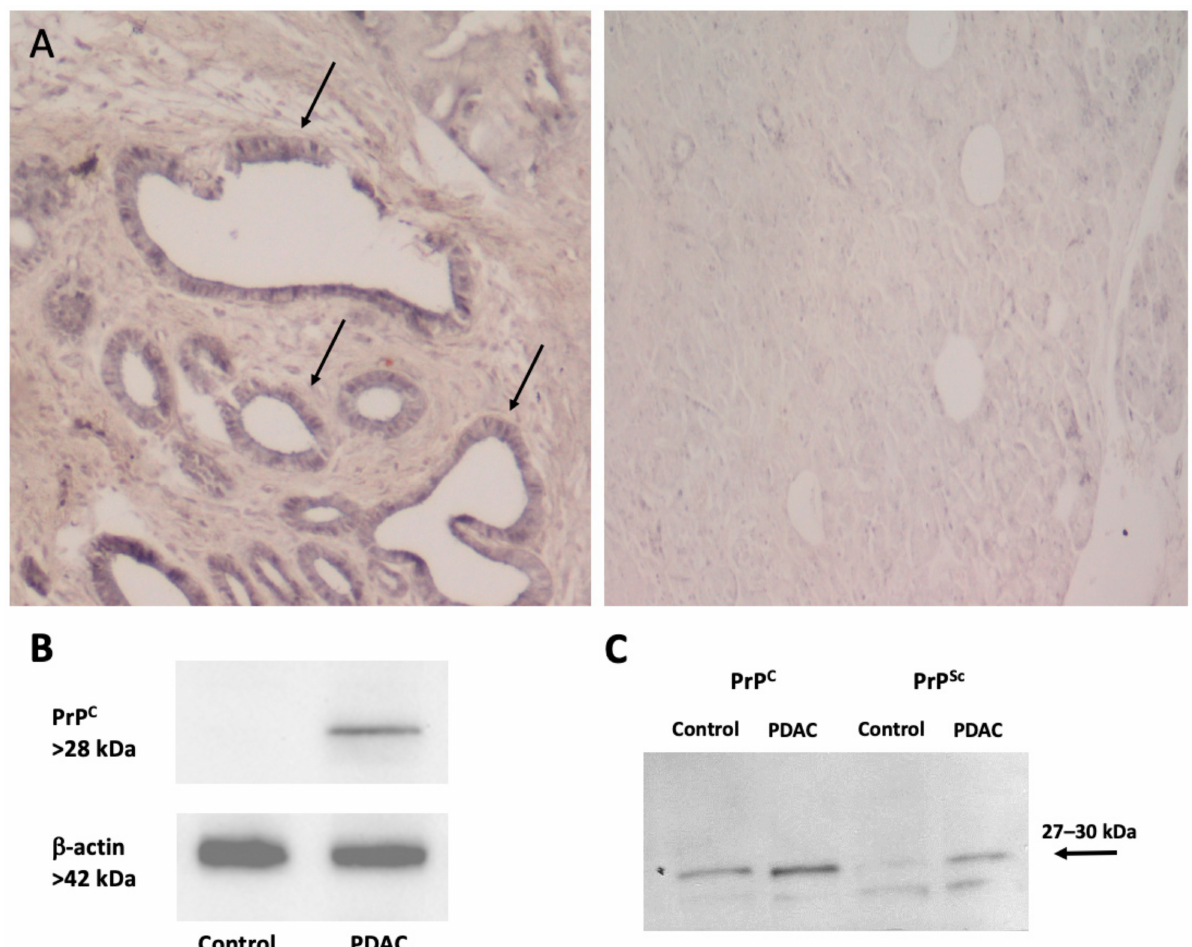
Figure 2. PrP C expression in human pancreatic tissues. ( A ) The figure reports representative pictures of PrP C immunohis- tochemistry of pancreatic ductal adenocarcinoma (PDAC) tissue (left panel) compared with control tissue (right panel). Immunoperoxidase shows PrP C -specific labelling in ductal cells (arrows) from a human tumor sample (left panel). Remark- ably, the increase in PrPc expression occurs along with a marked loss of cellular architecture within pancreatic tumoral tissue, which features enlarged and irregularly shaped ducts within abundant extracellular matrix. In contrast, normal human pancreas (right panel) possesses a well-preserved architecture of both acinar cells and ductal system, along with a weak PrP C -staining in the ductal epithelial cells (original magnification 10 × ). ( B ) The figure reports a representative immunoblot for PrP C and the house keeping protein β -actin in control and PDAC tissues. ( C ) The figure reports representative western blotting comparing scrapie prion protein (PrP Sc ) and PrP C (with or without proteinase K) in control and PDAC tissues as measured in Table 1. Images were obtained by an author of the manuscript (M.A. Giambelluca). Original western blot images (Figures S1 and S2) and densitometry readings (Tables S1 and S2) were provided in Supplemental